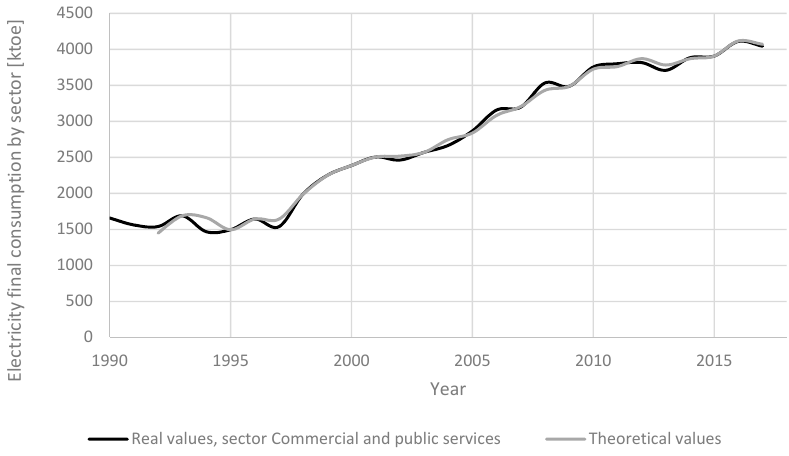
Figure 10. The comparison of the theoretical and actual values of final electricity consumption for residential sector, ktoe, source: own study.